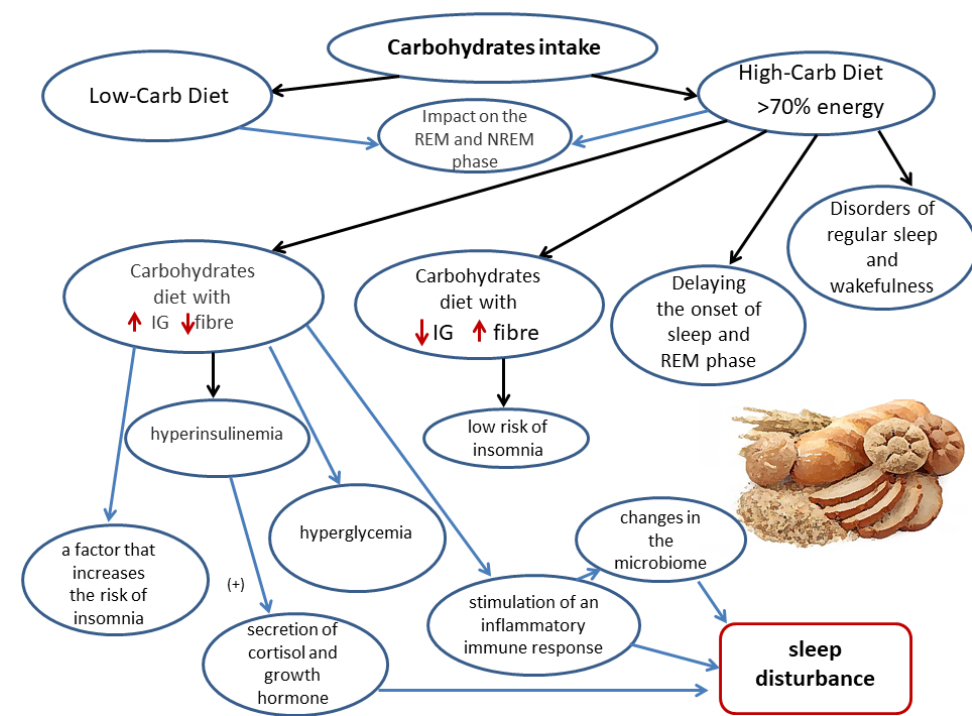
Figure 4. Carbohydrates and sleep